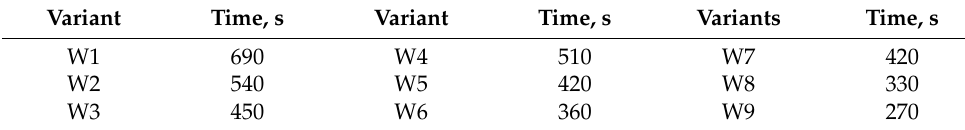
Table 4. Refining time to eliminate 90% of dissolved oxygen for studied variants.